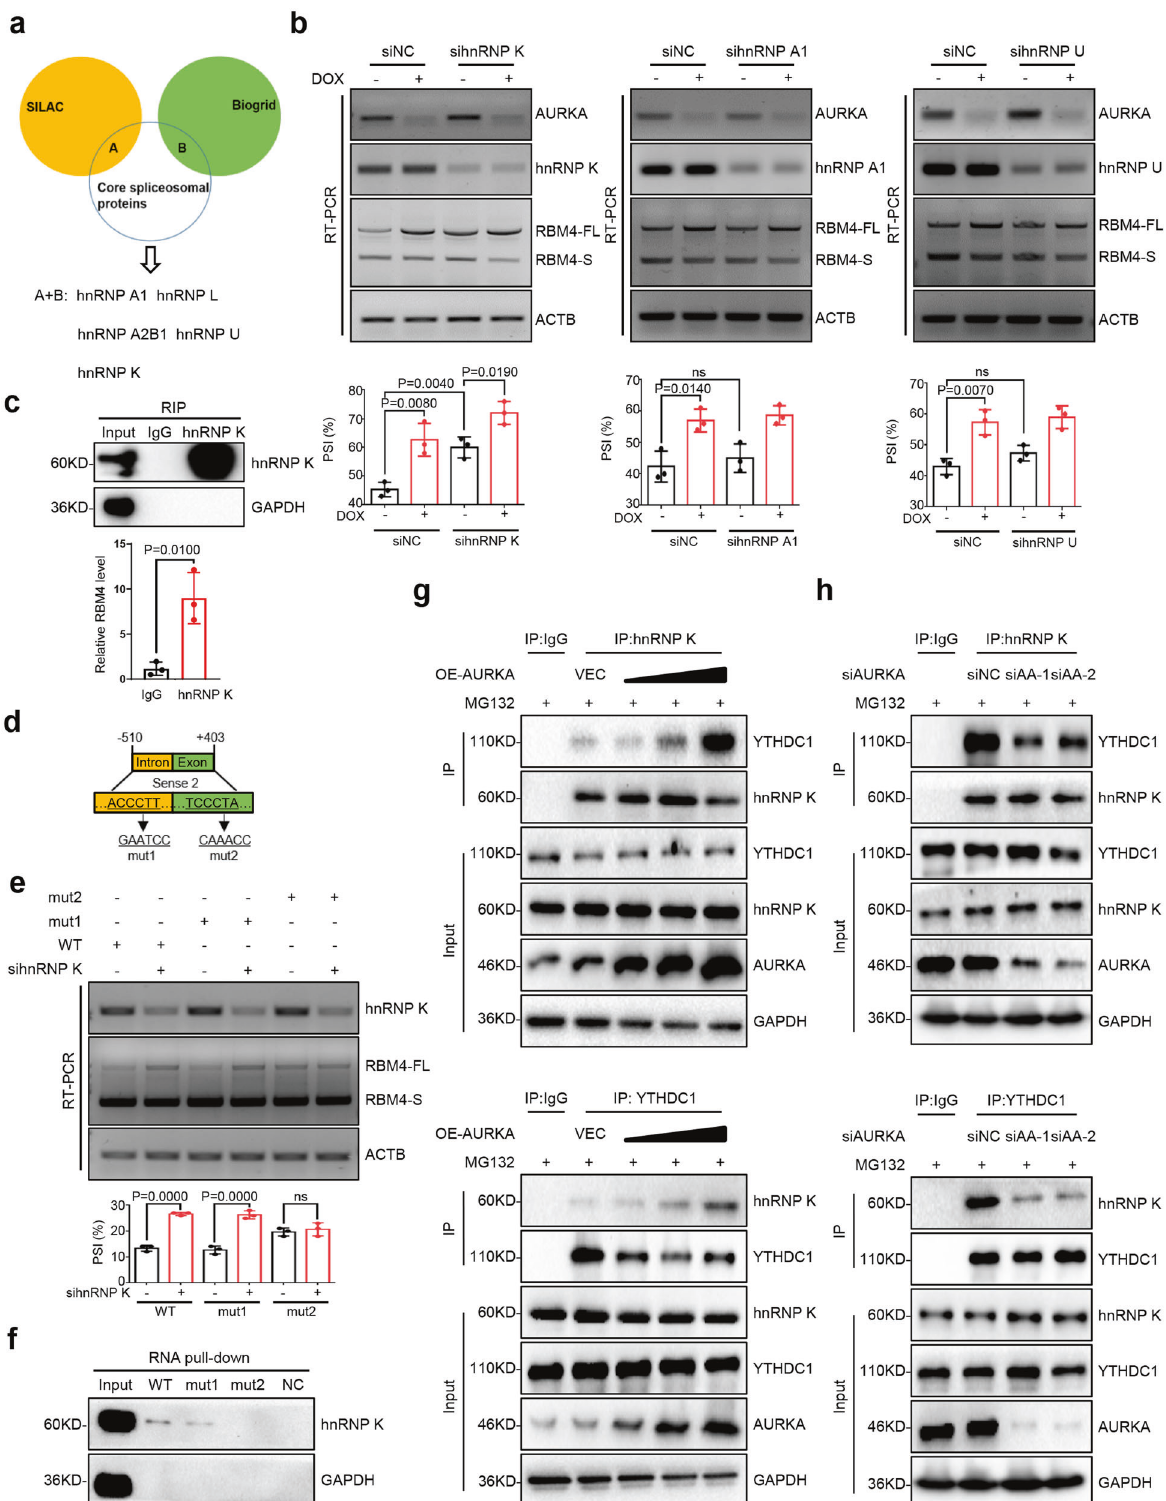
Clinical relevance of AURKA-RBM4 aberrant splicing axis To explore the clinical relevance of the AURKA-RBM4 aberrant splicing axis, we collected 8 pairs of non-small cell lung cancer (NSCLC) specimens and adjacent normal tissues to measure the protein levels of AURKA and RBM4 two splicing isoforms. Compared with adjacent normal tissues, the relative protein